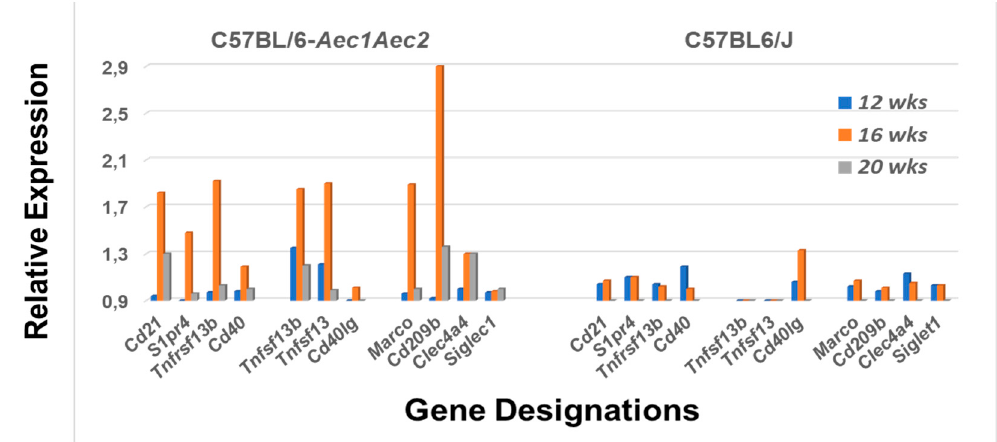
Figure 4. Differential expression profiles for genes encoding various receptors associated with the MZB cell function. Comparative transcriptome data showing the temporal expression of MZB cell-associated receptor genes ( Cd21 , S1pr4 , Tnfrsf13b and Cd40 ), receptor ligands ( Tnfsf13b , Tnfsf13 and Cd40lg ) and macrophage receptors ( Marco , Cd209b , Clec4a4 and Siglec1 ) in salivary glands of SS S C57BL/6.NOD- Aec1Aec2 mice ( left ) versus SS NS C57BL/6J mice ( right ).